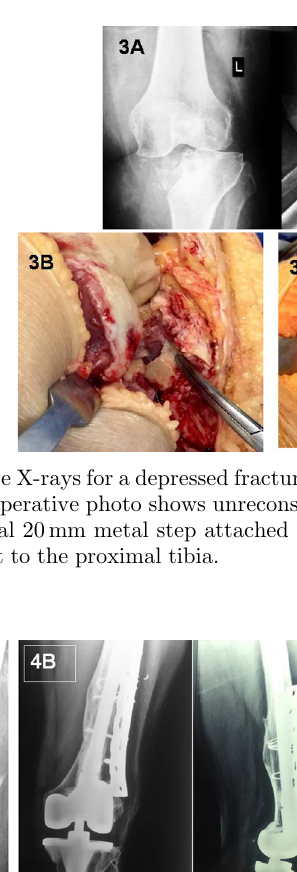
Figure 2. (A)PreoperativeCTscanshowinglateraldepressionofthetibialplateauandmedialjointarthriticchanges.(B)Intra-articular photoafterproximaltibialcut.Lateraldepressedarticularsurfacewithremainingcartilagecovering.(C)Peripheralbonedefectafterremoval of the depressed articular cartilage. (D) Postoperative X-ray with a stem added to the tibial tray and cement fi lling of the lateral defect.